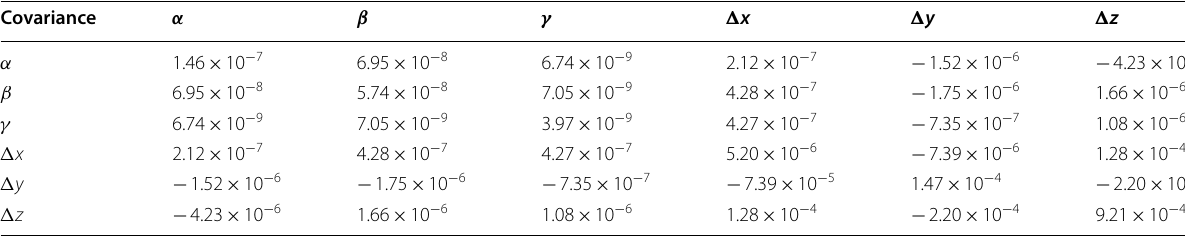
Table 5 Covariance matrix of α , β , γ , � x , � y , � z (mm 2 ) Covariance α β